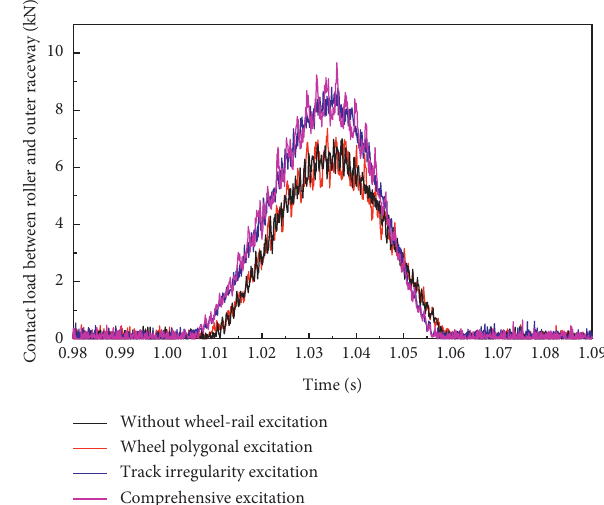
Figure 18: Contact load time history of the roller and outer